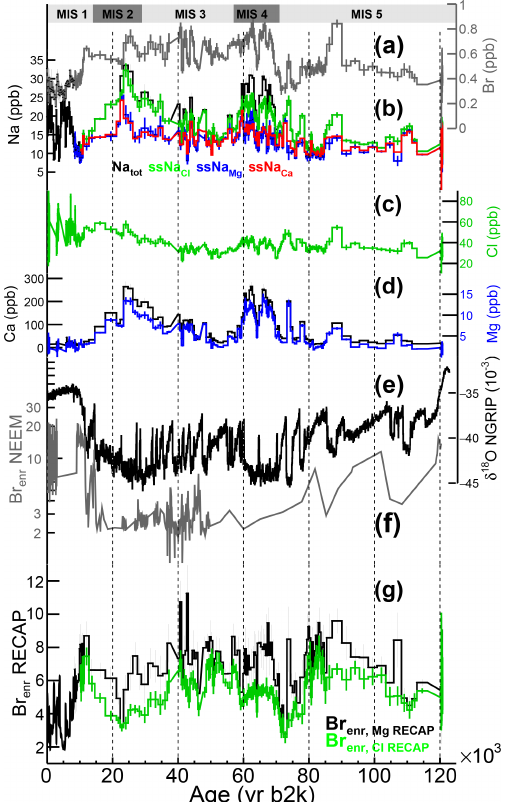
Figure 4. The 120kyr time series of analyte concentrations in the RECAP ice core. The last 8kyr are 100-year averages. (a) bromine; (b) total sodium and sea-salt sodium (ssNa) series calculated us- ing chlorine (green), magnesium (blue) and calcium (red); (c) chlo- rine; (d) calcium (black) and magnesium (blue); (e) NGRIP δ 18 O from North Greenland Ice Core Project members (2004); (f) NEEM Br enr from Spolaor et al. (2016b); (g) RECAP Br enr series (Br enr , Cl , green and Br enr , Mg , black) calculated using chlorine and magne- sium